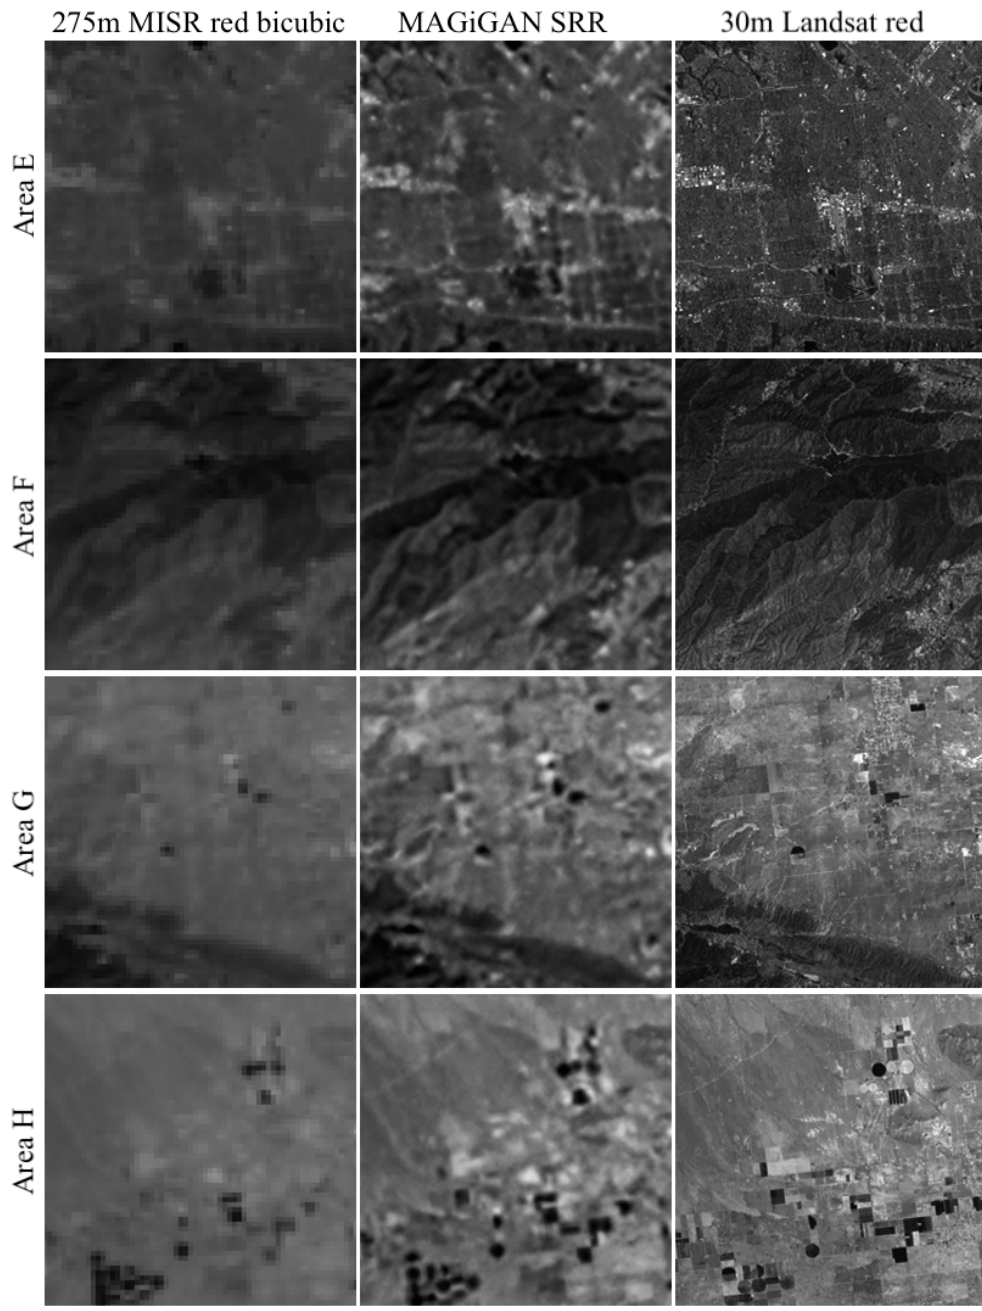
Figure 4. MISR red band SRR results at Sky Zone Trampoline Park urban and countryside region in comparison with the original 275 m MISR red band image (bicubic interpolated to the same scale as SRR image) and 30 m Landsat red band image.